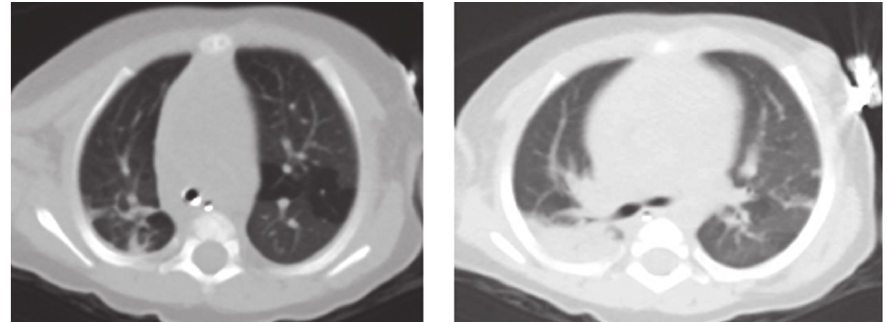
Figure 2: CT chest: bibasilar atelectasis with several areas of air trapping bilaterally. No definite evidence of interstitial lung disease. Enlarged